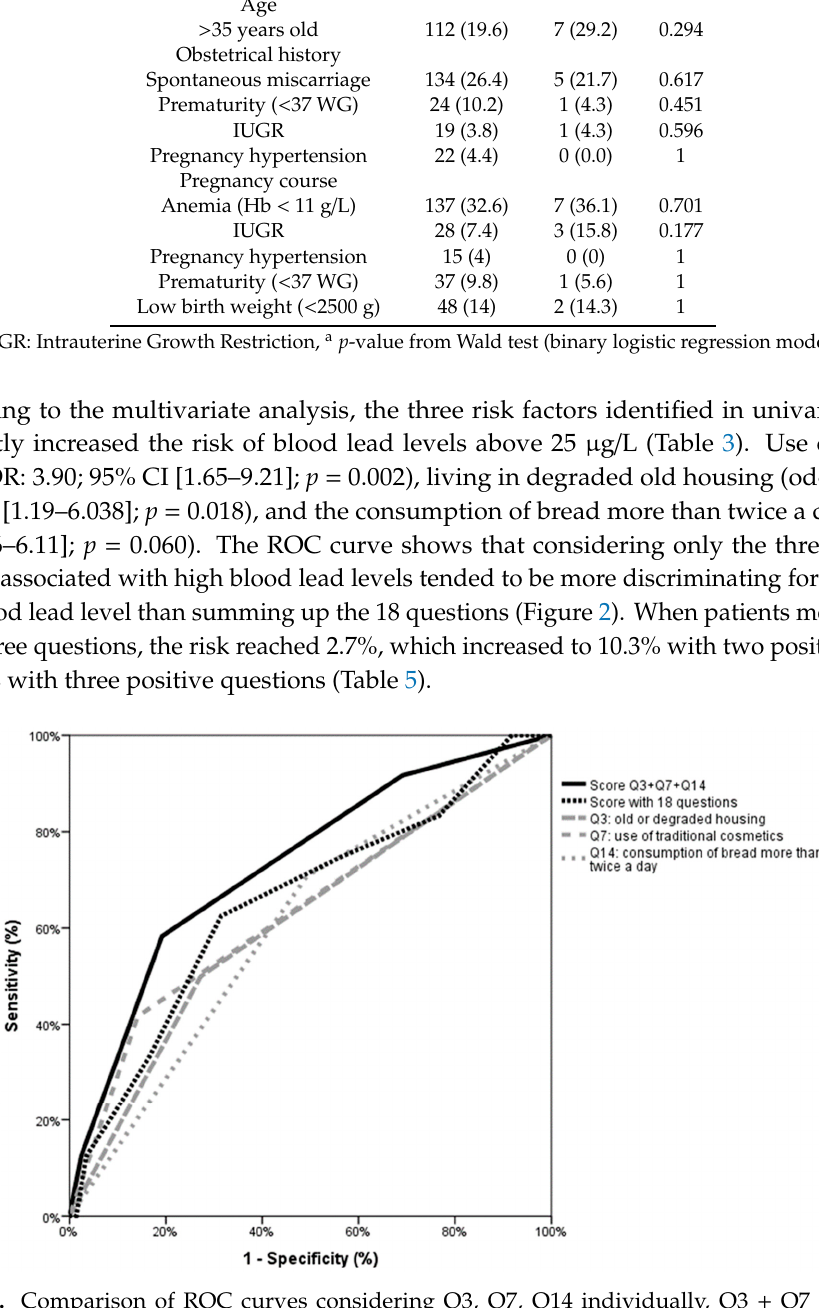
Figure 2. Comparison of ROC curves considering Q3, Q7, Q14 individually, Q3 + Q7 + Q14 or all 18 questions. When all 18 questions were considered, the area under the curve was 0.654 (95% confidence interval (CI) [0.538–0.771], p = 0.010). When only the three significant questions were taken into account the area under the curve is 0.731 (95% CI [0.626–0.836], p < 0.001). Individual areas under the curve (AUCs) for those teach three questions are 0.614 (95% CI [0.493–0.734]) for Q3, 0.638 (95% CI